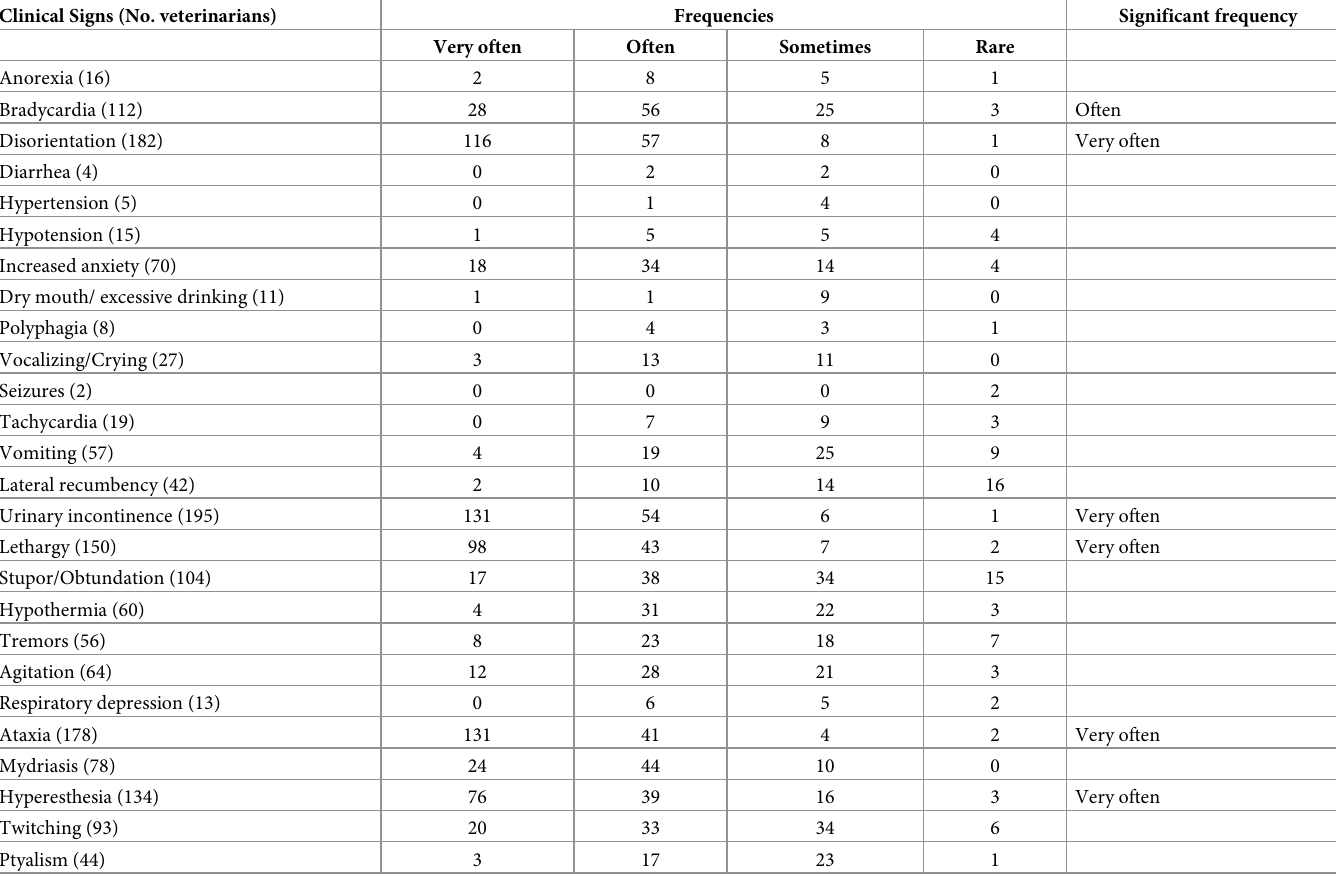
Table 1. Aggregate data about cannabis toxicosis clinical signs and their frequencies reported by Canadian and American veterinarians. Clinical Signs (No.